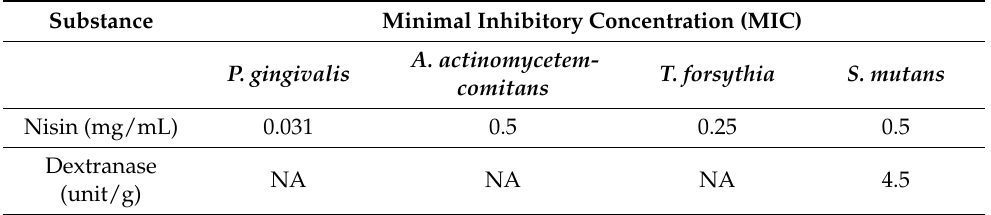
Table 2. The MIC of the nisin and dextranase against the representative pathogens. NA: no activity.